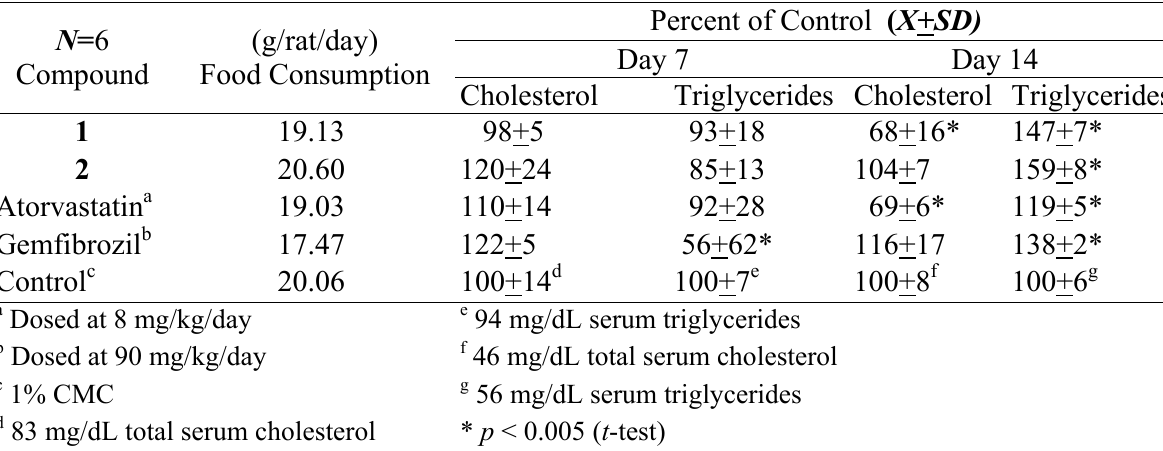
Table 2: In Vivo Hypolipidemic Activity of the 2,3,4-trisubstituted pyrroles ( 1 ) and ( 2 ) in Sprague-Dawley Rats at 2 mg/kg/day orally for 14 days.